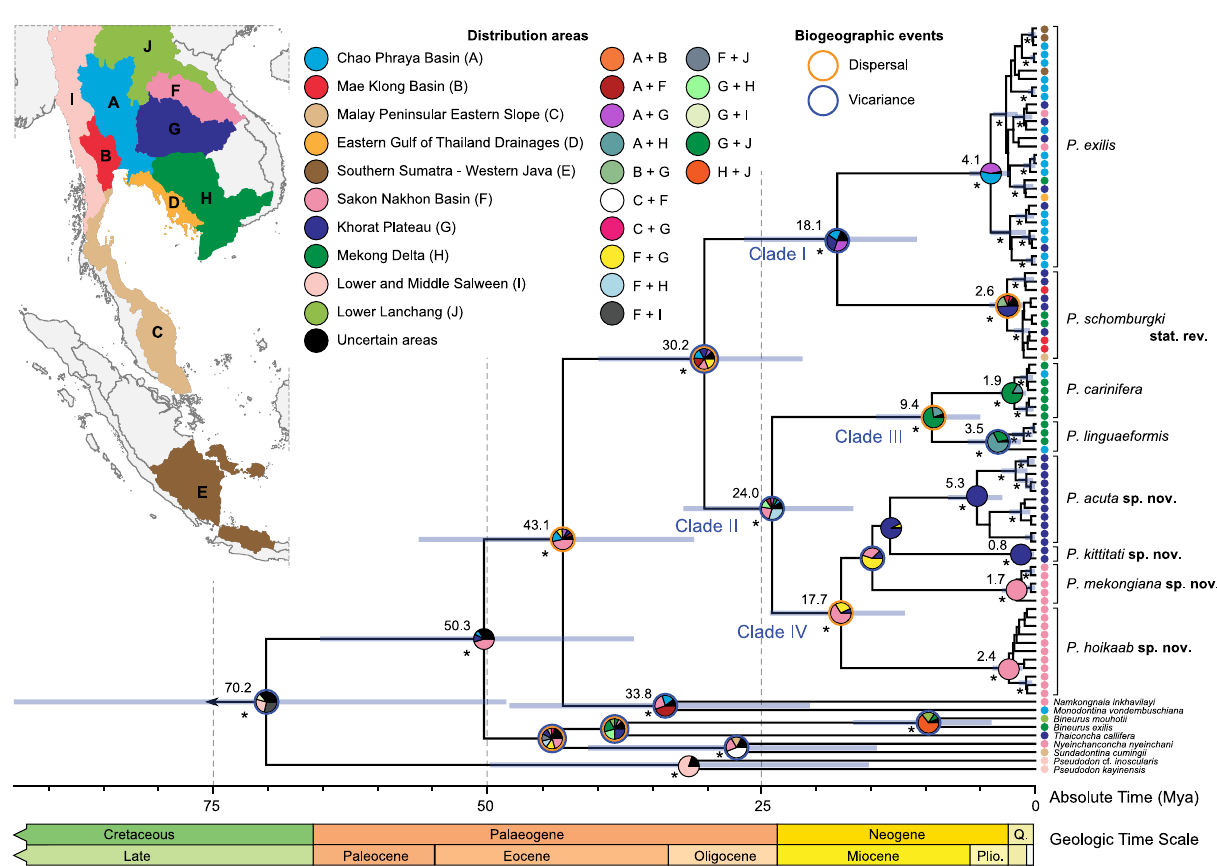
Figure 2. Fossil-calibrated ultrametric tree of the tribe Pseudodontini generated from BEAST v2.6.1 26 based on the concatenated alignment dataset of COI + 16S + 28S genes. The outgroup sample is not shown. Sufficiently supported nodes (bpp ≥ 0.95) are marked with “*”. Numbers above branches are estimates of time since the most recent common ancestor (tMRCA). Node bar indicates 95% highest posterior density interval (HPD) of the node ages. Pie charts at nodes indicate probabilities of certain ancestral areas from the combined results calculated by the common area reconstruction. Border color of the pie charts indicates biogeographic events of dispersal (orange border) and vicariance (blue border) events. Map shows the boundaries of freshwater basins used in the ancestral area reconstruction analysis. Map was modified from the GIS shapefile from Freshwater Ecoregions of the World (https:// www. feow. org). Geologic time scale according to the geological Society of America 81